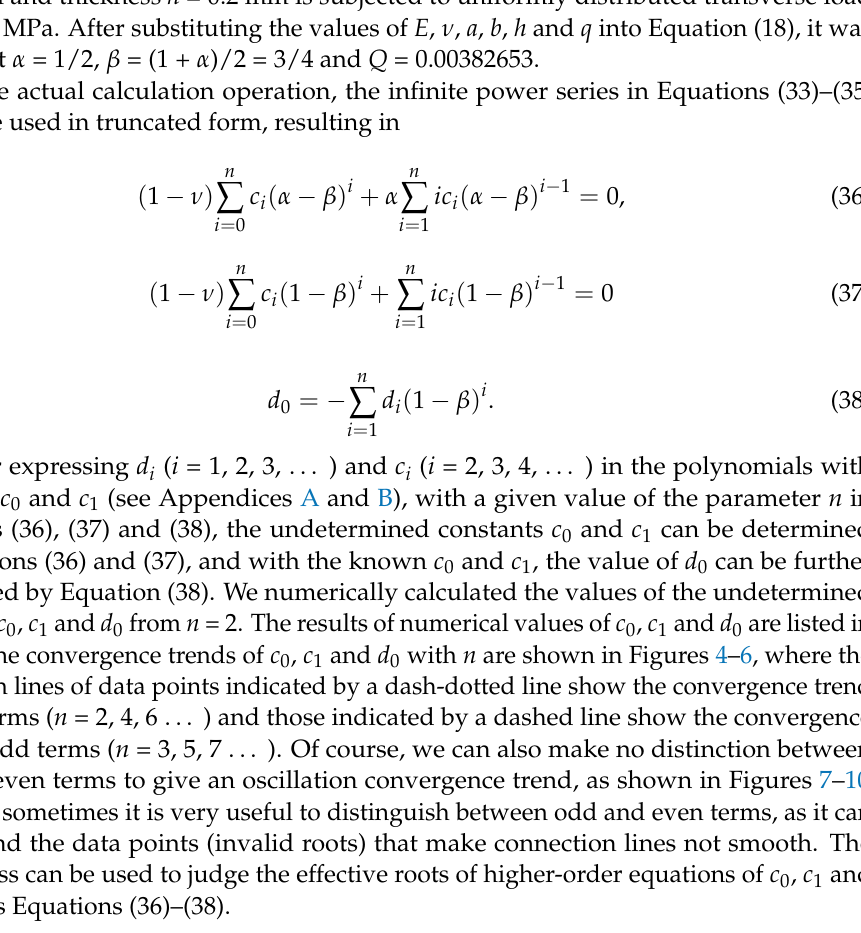
Figure 5. Variation of c 1 with n .